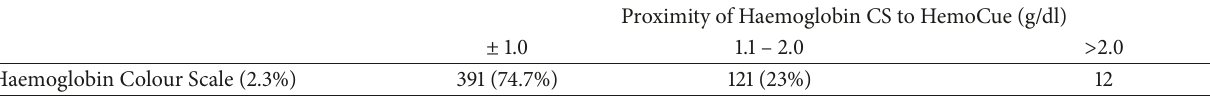
Table 2: Proximity of the HCS to the HemoCue results obtained through cross-tabulation of both